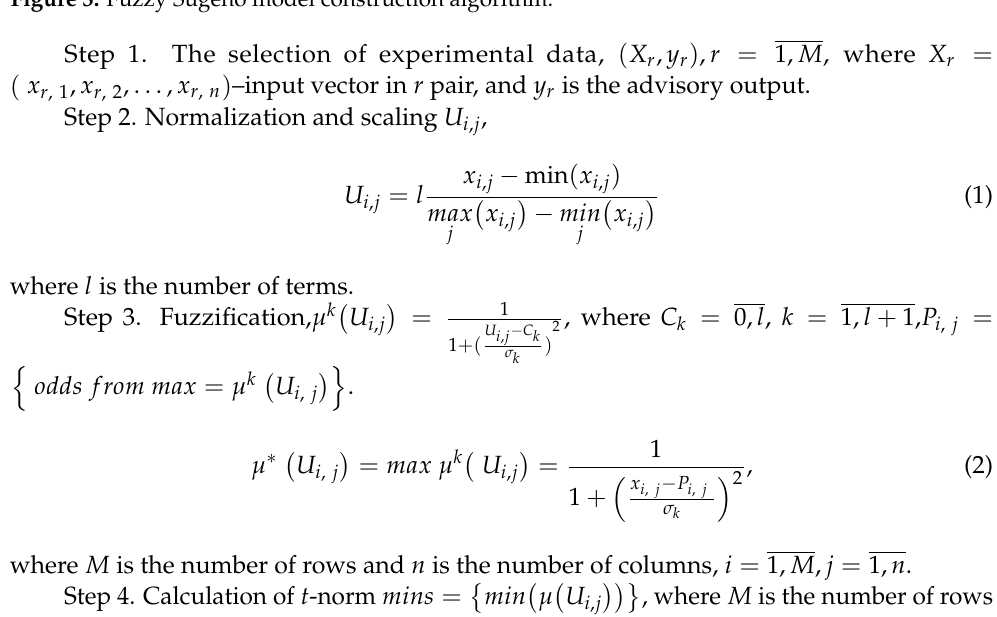
Figure 3. Fuzzy Sugeno model construction algorithm.